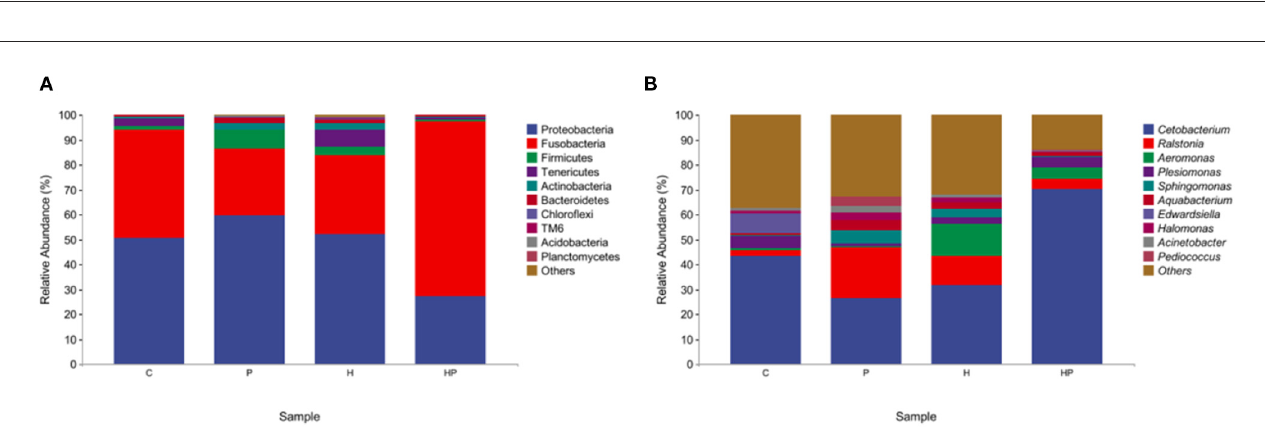
FIGURE4 The gut microbiota of zebrafish in C, P, H, and HP groups. Relative abundance at phylum (A) and genus (B) level of the gut microbiota.